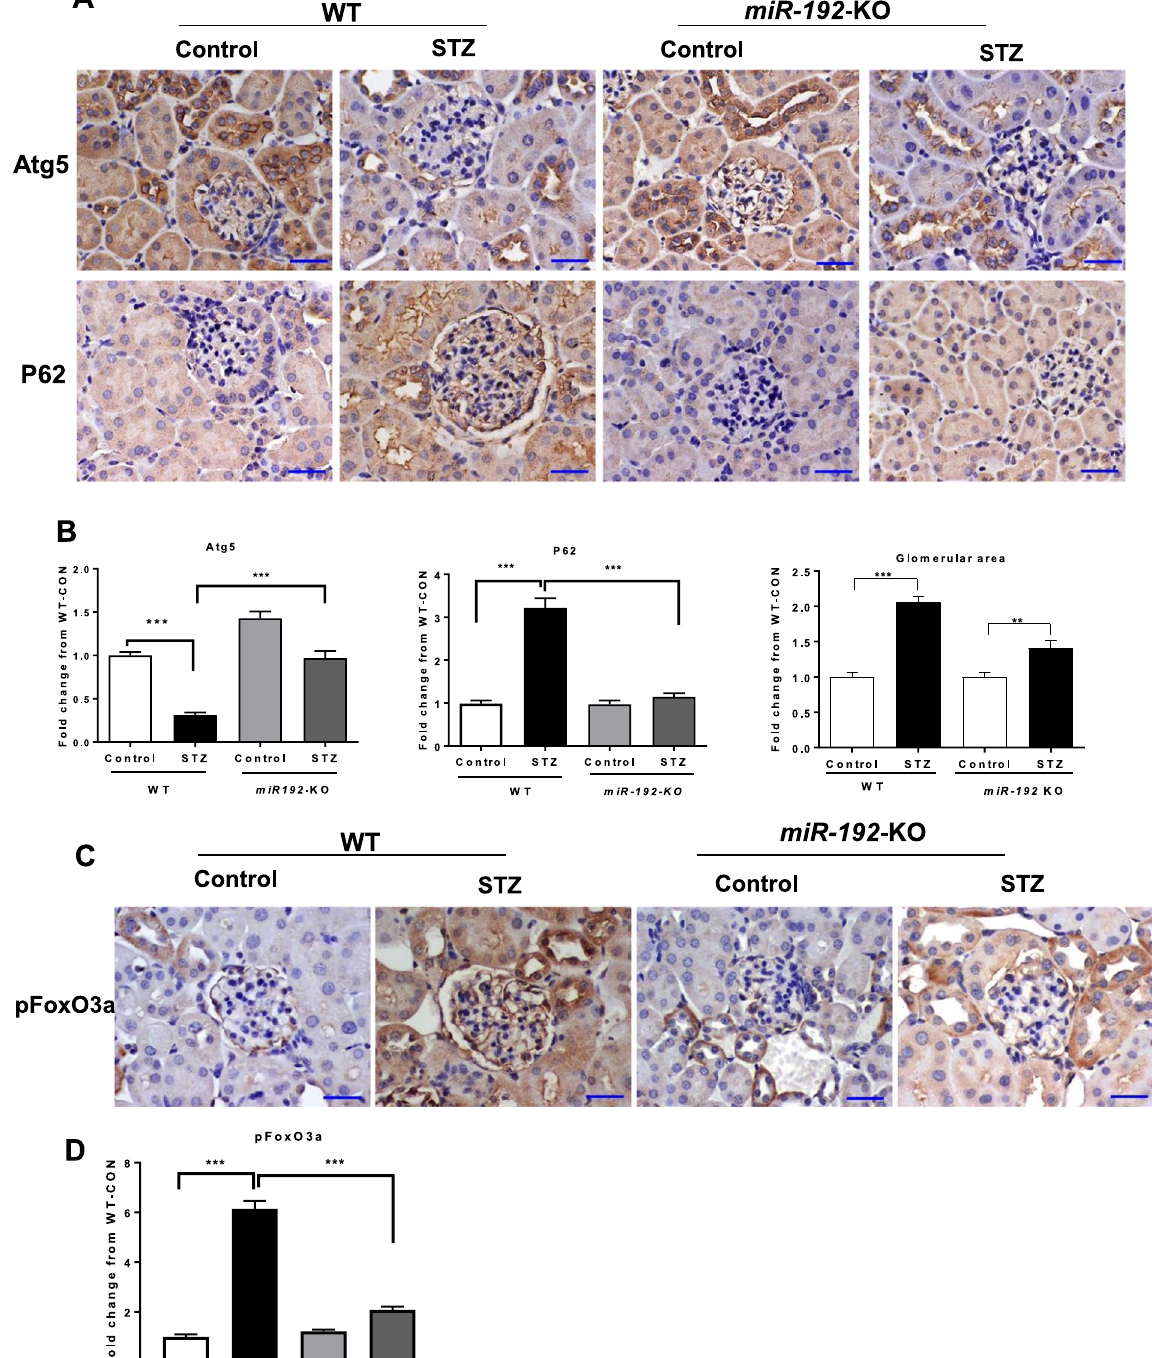
Figure 4. Autophagy is not decreased in kidneys of STZ-injected type-1 diabetic miR-192-KO mice compared to control mice. ( A ) Representative immunostaining and quantification for p62, Atg5 and glomerular area from cortical sections of 22-week old control and STZ-injected -WT and miR-192-KO mice; n = 5 per group. Scale bar, 20 µ m. x400 (10 × 40) magnification. ( B ) Bar graphs showing quantification for p62, Atg5 and glomerular area. ** P < 0.01; *** P < 0.001. ( C ) Representative immunostaining and quantification for pFoxO3a from cortical sections of 22-week old control and STZ-injected -WT and miR-192-KO mice; n = 5 per group. Scale bar, 20 µ m. ( D ) Bar graphs showing quantification for pFoxO3a. *** P <